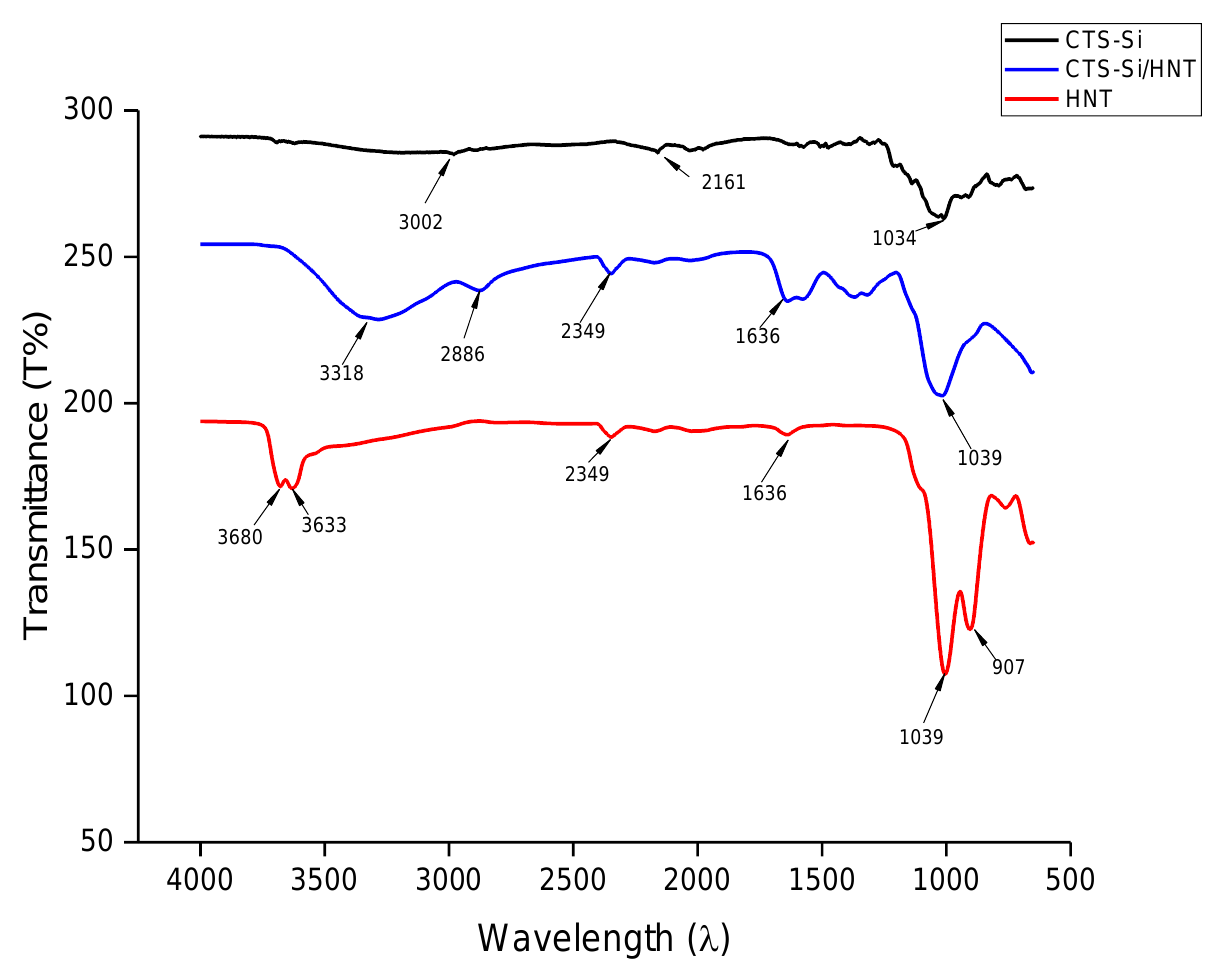
Figure 3. FTIR spectra of CTS-Si/HNT nanocomposite in comparison with CTS-Si and HNT.